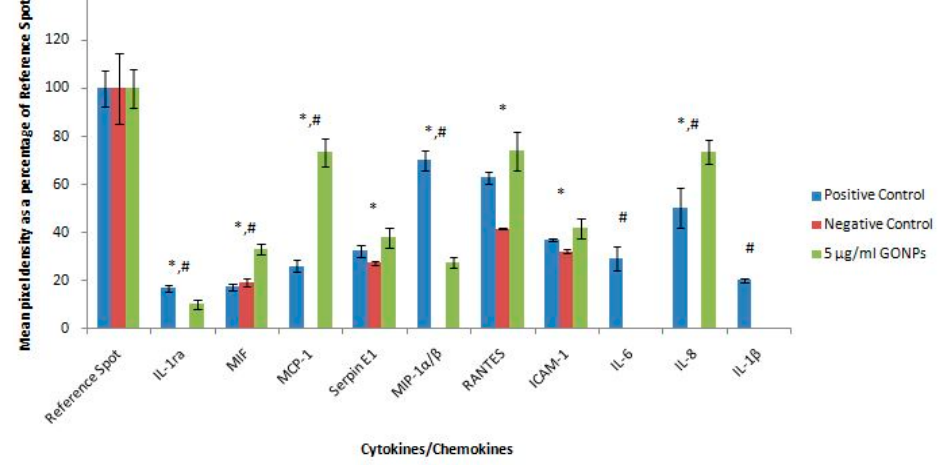
Figure 8. Quantification of cytokines secreted by whole blood cell cultures not stimulated with LPS after treatment with medium only or medium containing 5 μ g/mL GONPs. Membranes subjected to chromogenic exposure. Data is represented as mean ± SD. Bars marked with symbols indicate significant differences ( p < 0.01). Significance demarcated by: *—significantly different compared to the negative control ( p < 0.001), # —significantly different compared to the positive control ( p < 0.001).